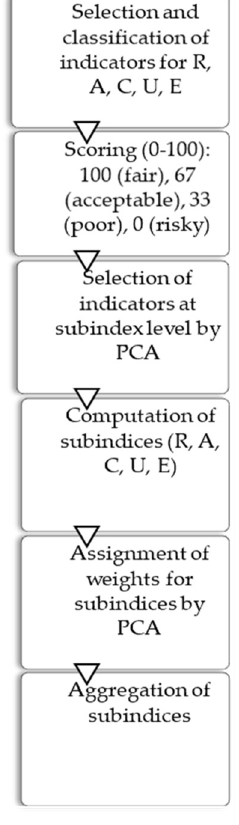
Figure 2. Methodological framework for construction of the WPI (note: R, A, C, U and E indicate Resource, Access, Capacity, Use and Environment, respectively).